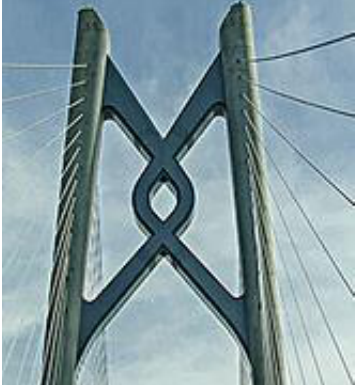
Figure 1. Inspection motion space scene diagram.